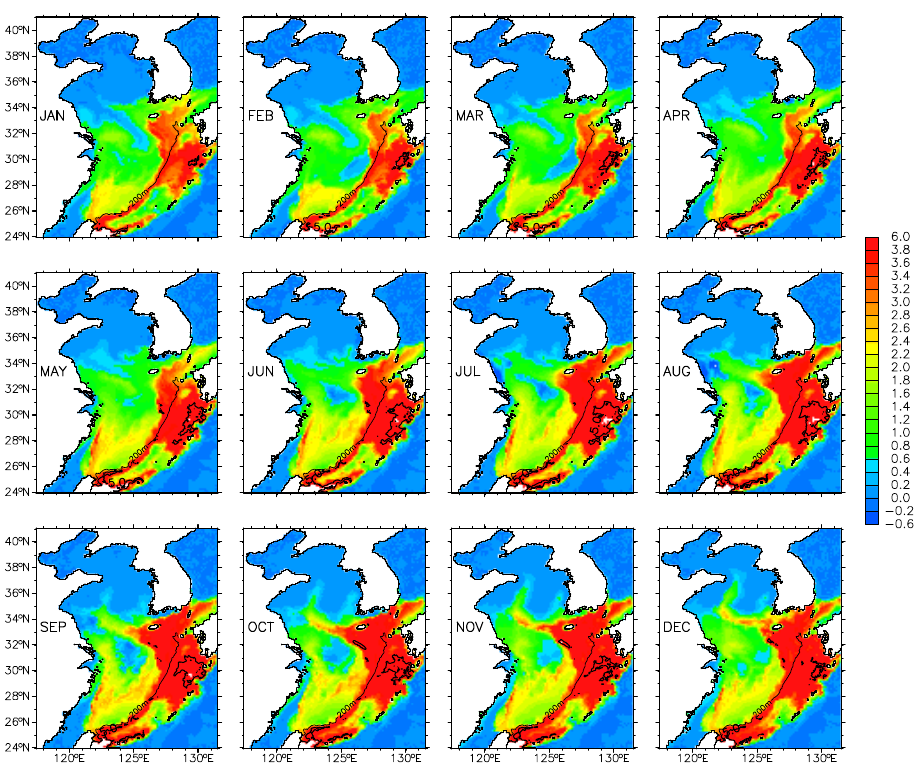
Fig. 13. The same as Fig. 12 but for DIN (mmolm − 3 ) in the bottom layer, defined as the deepest sigma layer. The color range is different from that used in Fig.